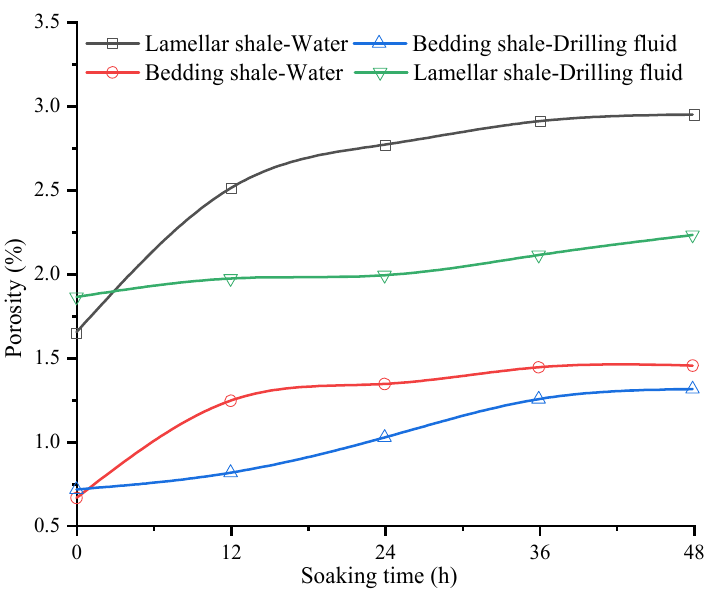
Figure 5. Relationship between shale porosity and soaking time under 0° sampling.